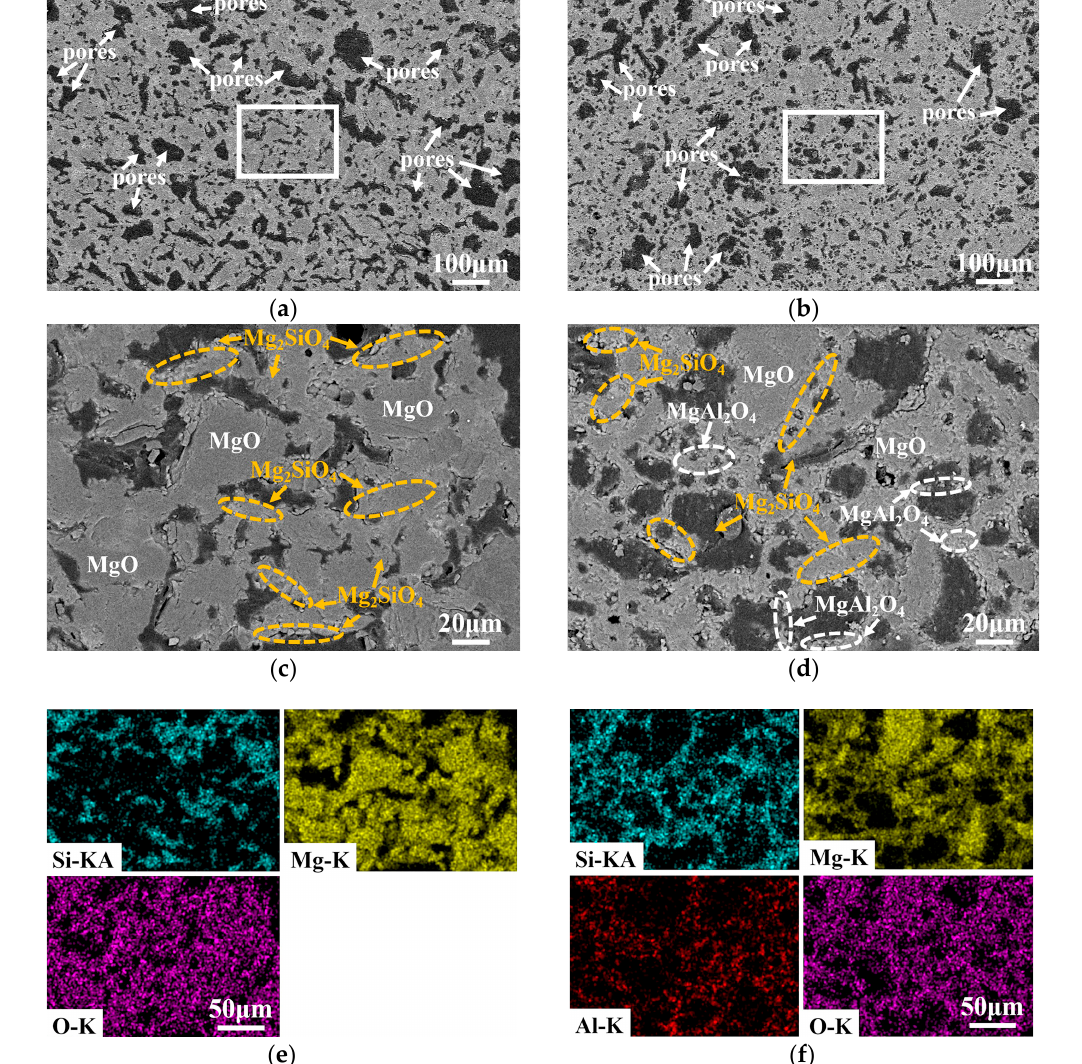
Figure 8. The back-scattered SEM of the oxidation layer and the corresponding element distribution in samples ASM0 ( a , c , e ) and ASM5 ( b , d , f ). High-resolution industrial CT was successfully applied to scan MgO-C samples to obtain the three-dimensional spatial positions of their constituents [14,18]. Based